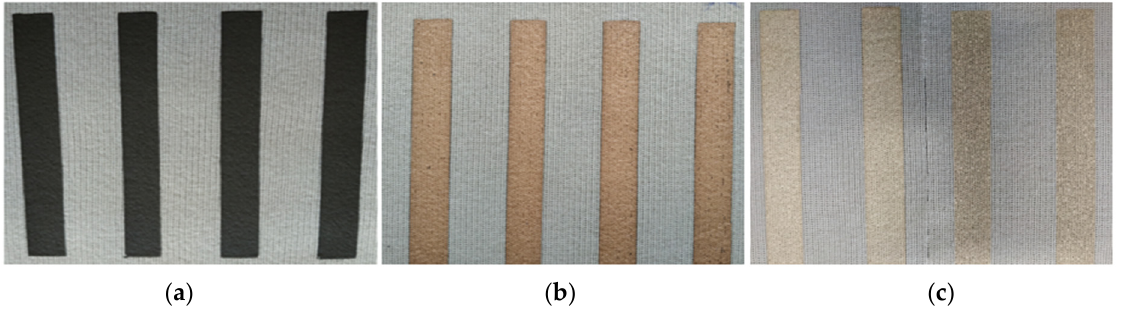
Figure 1. 3D printing of different conductive inks made of ( a ) carbon, ( b ) copper, and ( c ) silver coated on the textile substrate.